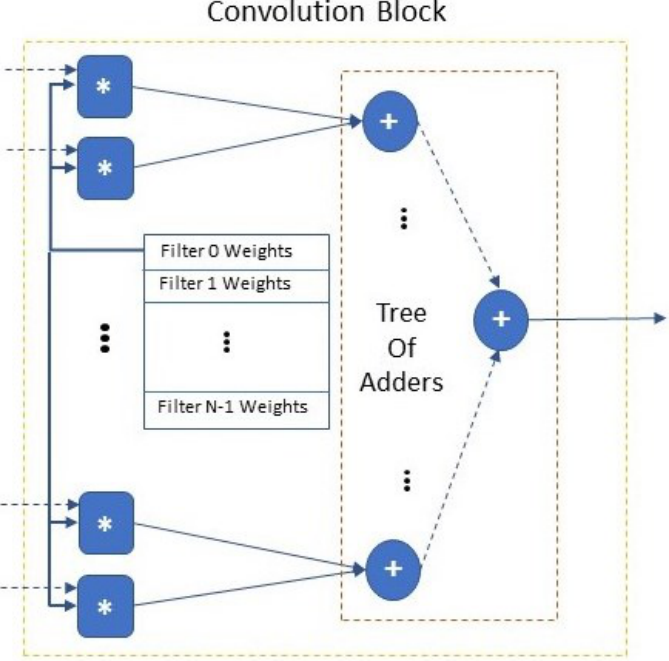
Figure 2. Convolution block architecture ( ∗ refers to fixed-point integer multiplication, + refers to fixed-point integer